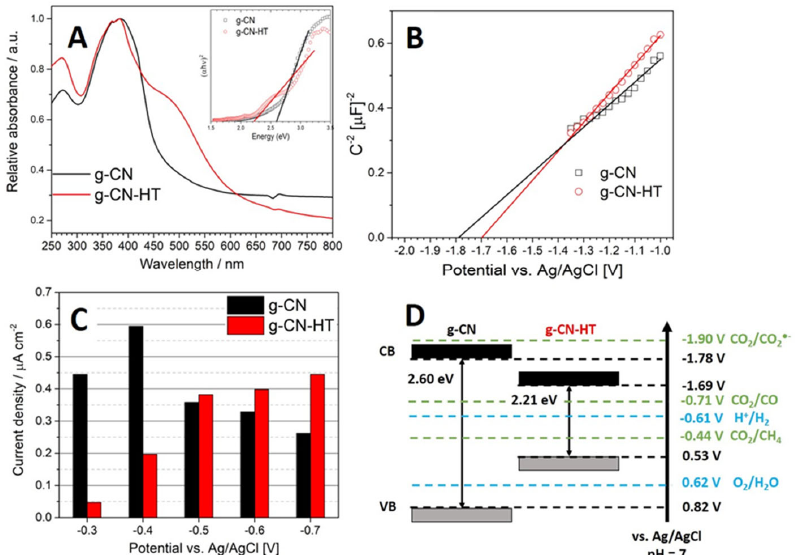
Figure 4. UV-Vis diffuse reflectance spectroscopy with the Tauc plot in the inset ( A ); Mott–Schottky plot obtained from dynamic electrochemical impedance spectroscopy at a 100 kHz frequency and 10 mV amplitude ( B ); photocurrent density determined from chronoamperometry experiments under illumination in CO 2 saturated 0.5 M KHCO 3 ( C ) and electronic band structure: grey band represents the valence band; black band represents the conduction band ( D ).